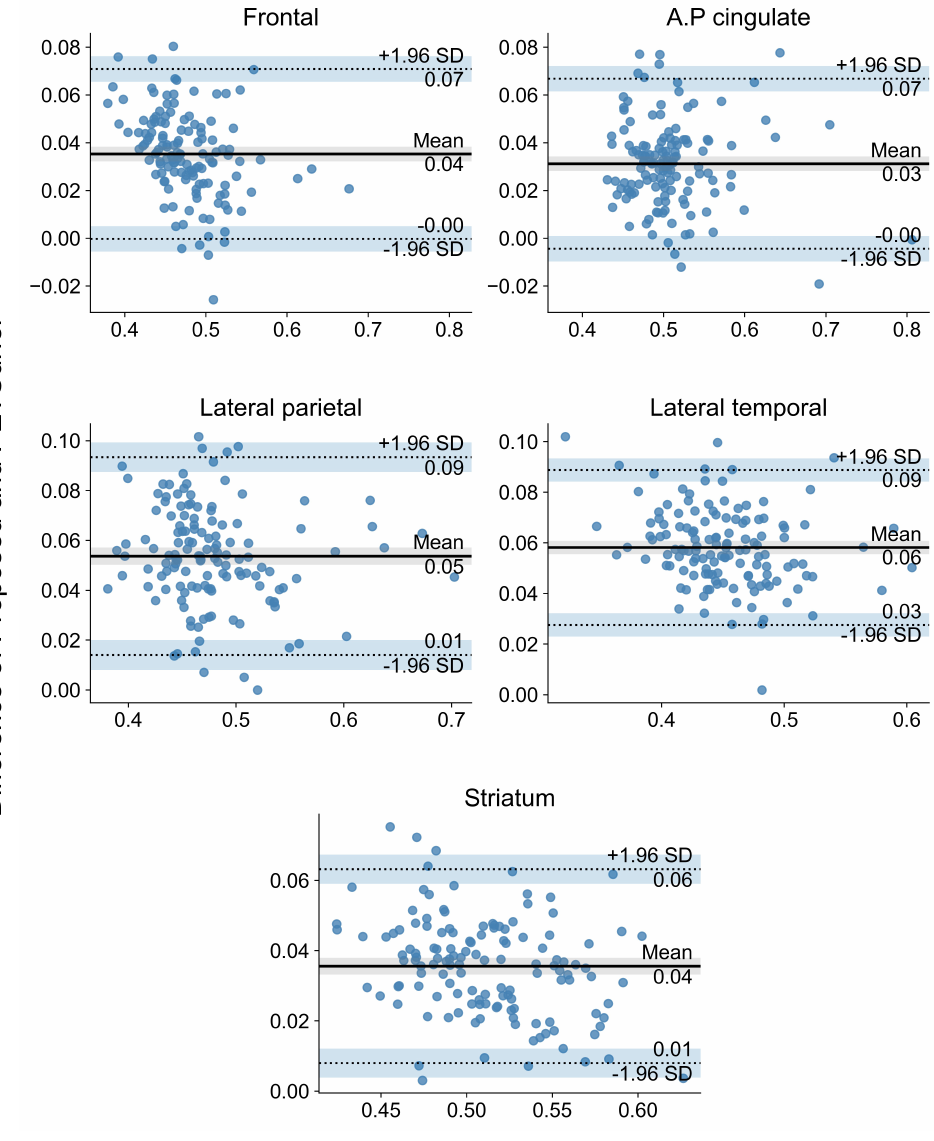
Figure A1. Bland–Altman plot for amyloidosis-negative subject for the comparison of our proposed method and PETSurfer. A.P. cigulate denotes anterior posterior cingulate